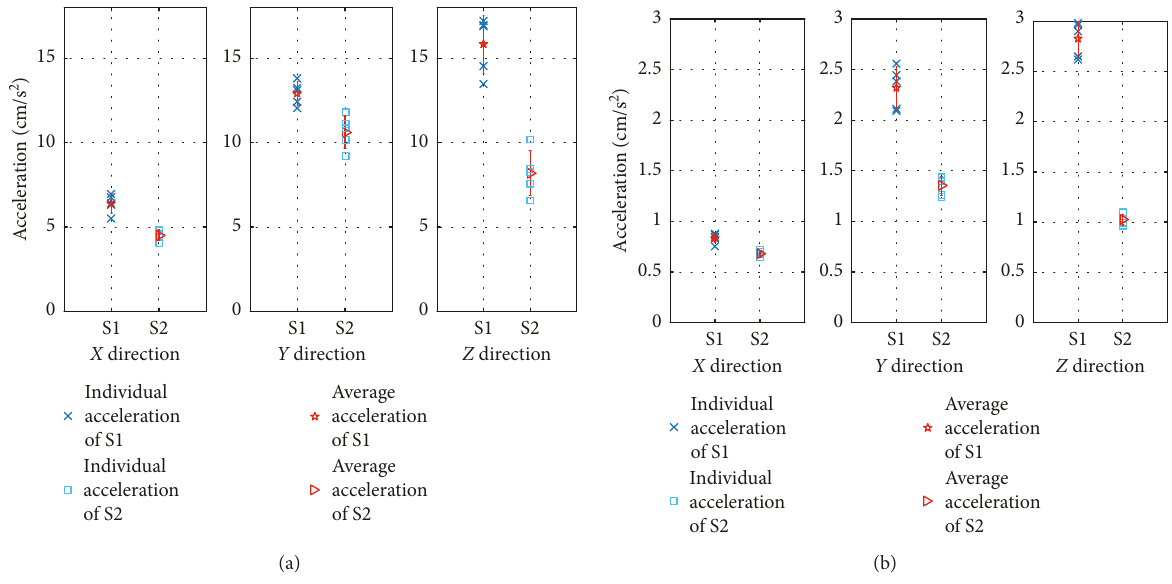
Figure 10: The average vibration acceleration of measuring points S1 and S2 induced by subway. (a) Peak values. (b) Rms values.